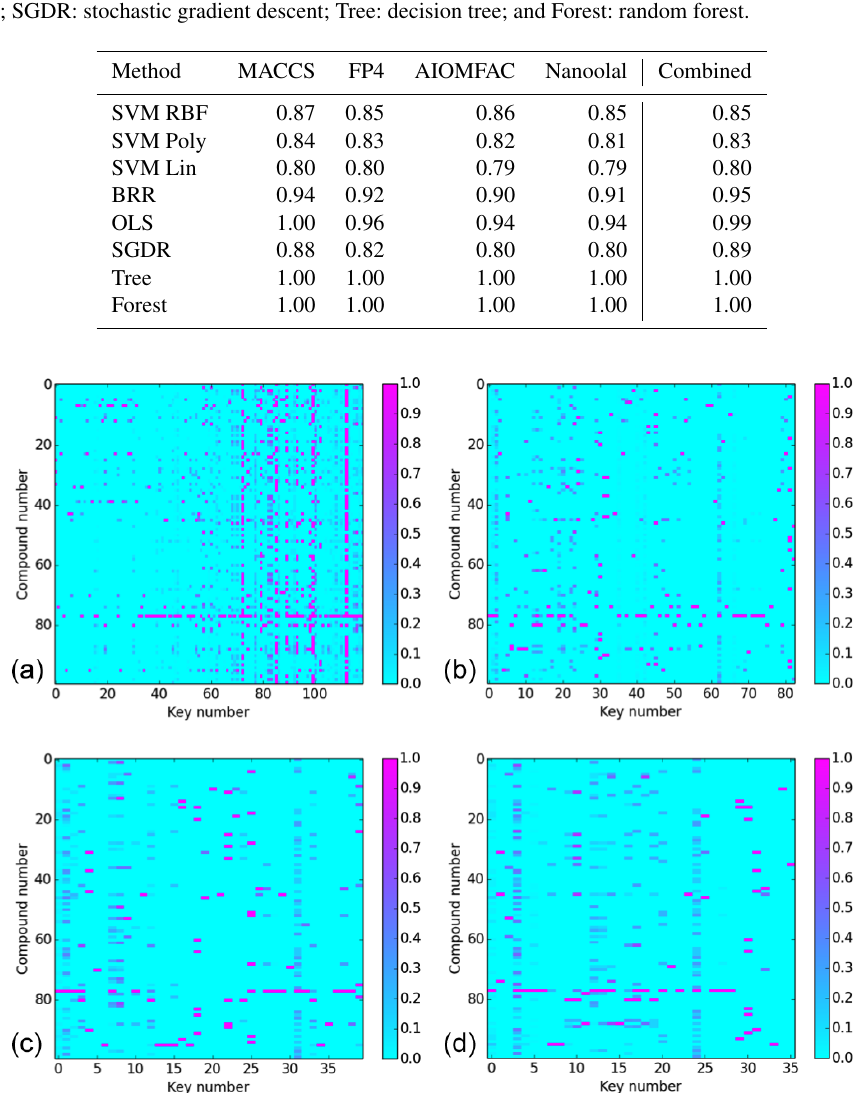
Table 1. Median cosine angle between measured and predicted spectra when fitting to the entire dataset as a function of molecular fingerprint (given above each column). Please note that the term “Combined” refers to a combination of all individual fingerprints into one. The method labels are as follows: SMV (support vector machine with three kernels (RBF, Poly(nomial) and Lin(near))); BRR: Bayesian ridge; OLS: